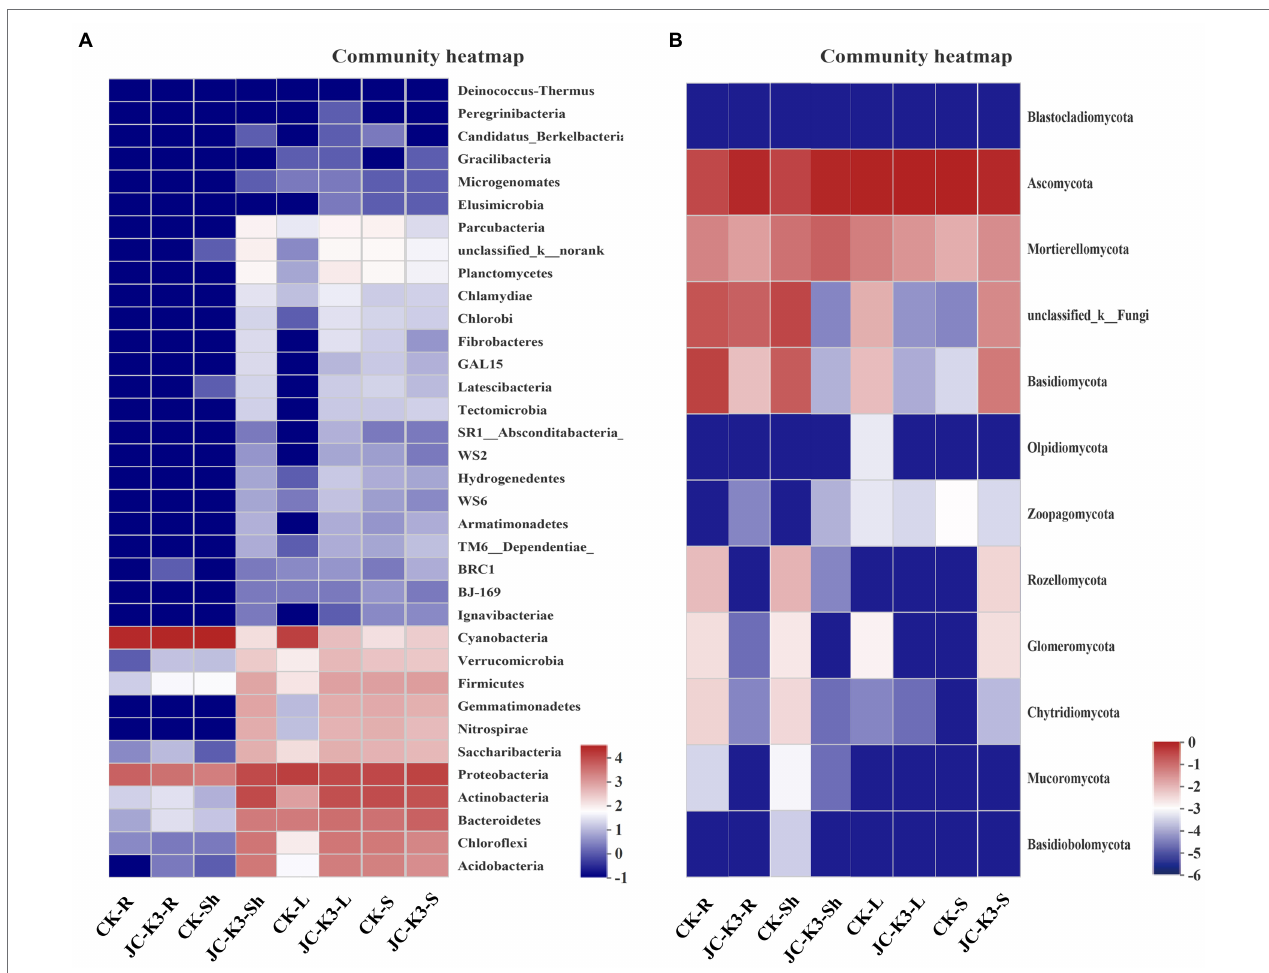
FIGURE 6 | Hierarchically clustered heatmaps of the bacterial (A) and fungal (B) distributions. The heatmaps show the distribution of different communities from two groups at the phylum level. CK and JC-K3 represent the control and JC-K3 inoculated plants, respectively. S, soil; R, roots; Sh, shoots; and L,